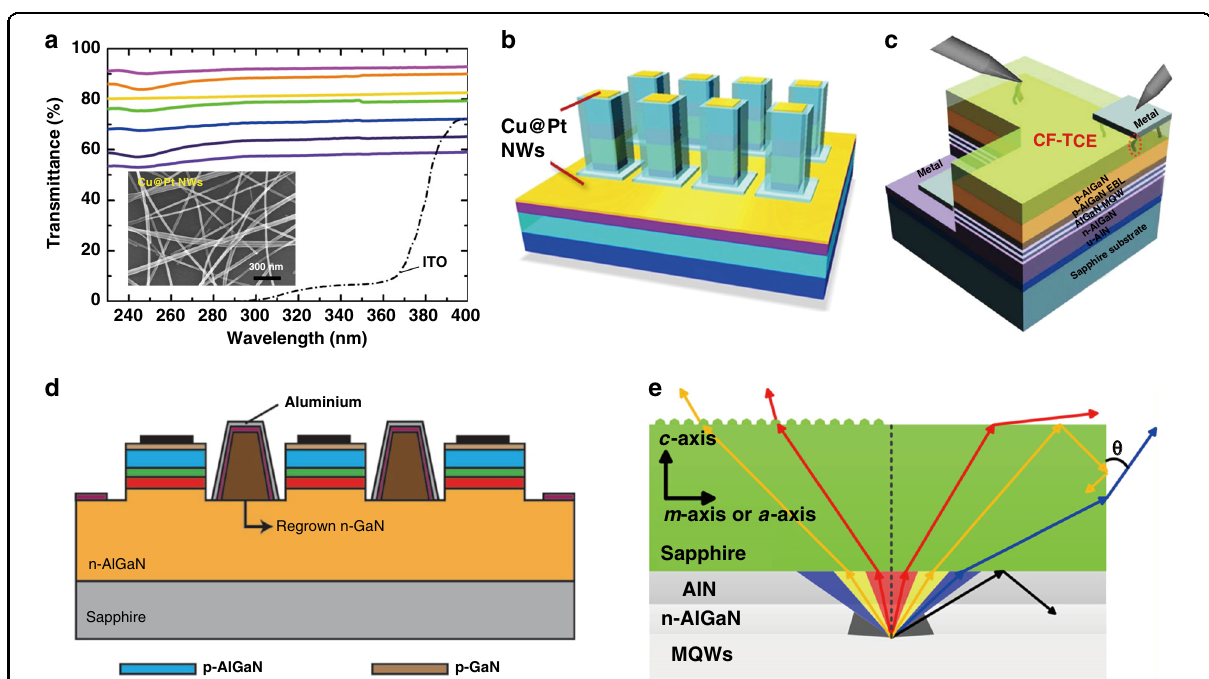
Fig. 9 Transparent and re fl ective electrodes for UV bands. a UV − vis transmission spectra for Cu NWs electrodes and ITO. The inset is the SEM image of Cu@Pt NWs network. b Schematic illustration of the complete structure of AlGaN-based DUV LED with Cu@Pt NWs transparent electrodes. c Schematic of the AlGaN-based UV LED with the conductive- fi lament transparent electrodes. d Schematic of DUV LED with regrown n-GaN-based Al mirror between the narrow mesa stripe structures. e Light propagation characteristics in DUV LED with moth-eye microstructure fabricated on the backside of a sapphire substrate. Figures reproduced from a ref. 114 , © 2013 Springer Nature; b ref. 25 © 2020, American Chemical Society; c ref. 116 , © 2013 John Wiley and Sons; d ref. 117 , © 2015 Springer Nature; e ref. 42 , © 2018 American Chemical